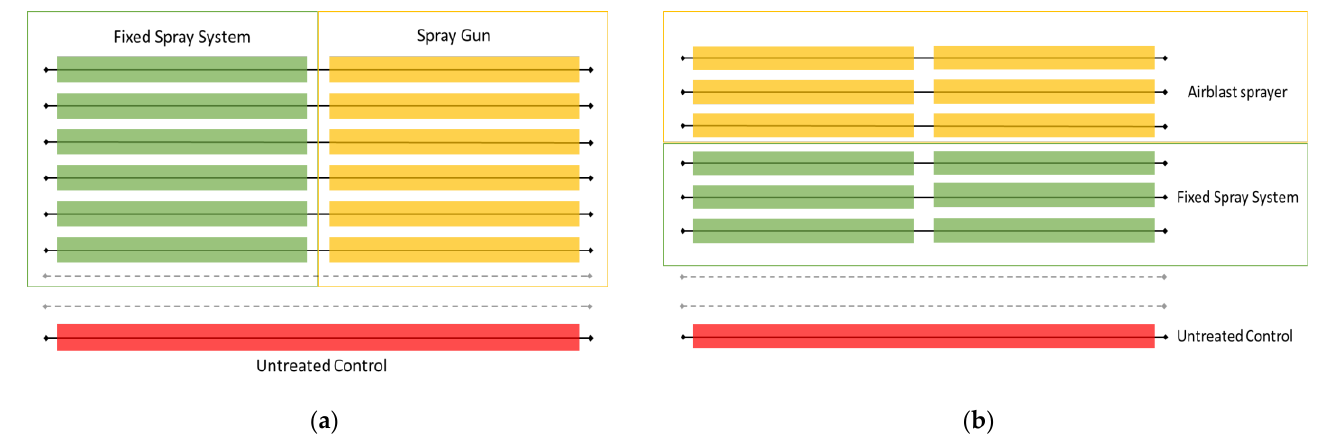
Figure 2. Experimental design in the Vidor vineyard ( a ) and in the Soave vineyard ( b ).